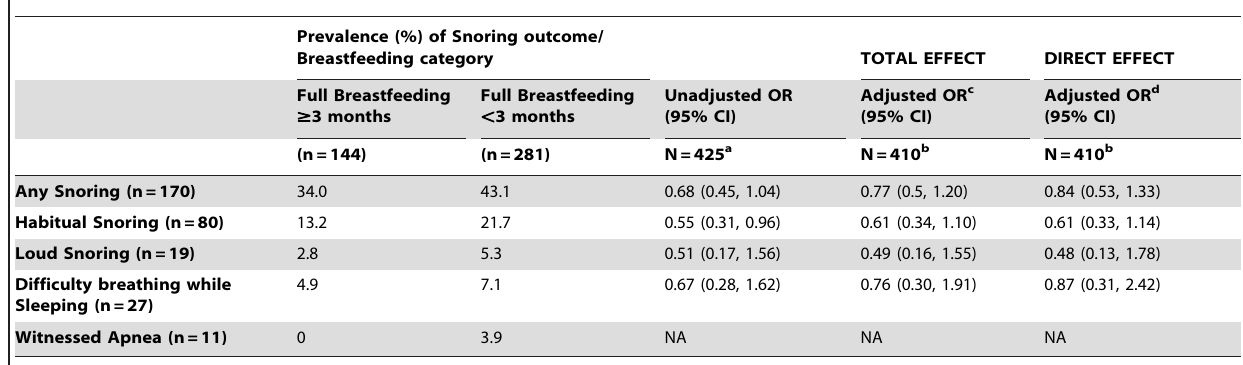
Table 2. Full Breastfeeding for more than 3 months and Snoring Outcomes.